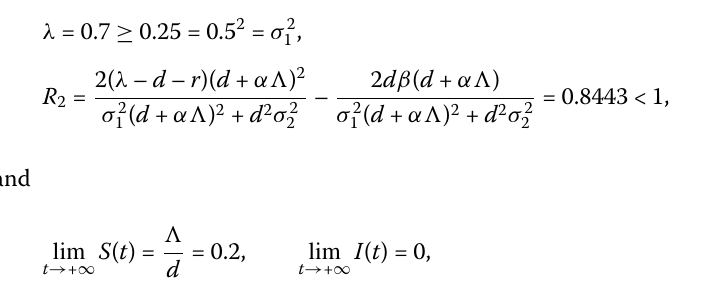
which satisfy case (i) of Theorem 2.1. For Figure 2(a) with σ 1 = 0.5 and σ 2 = 0.2, we get